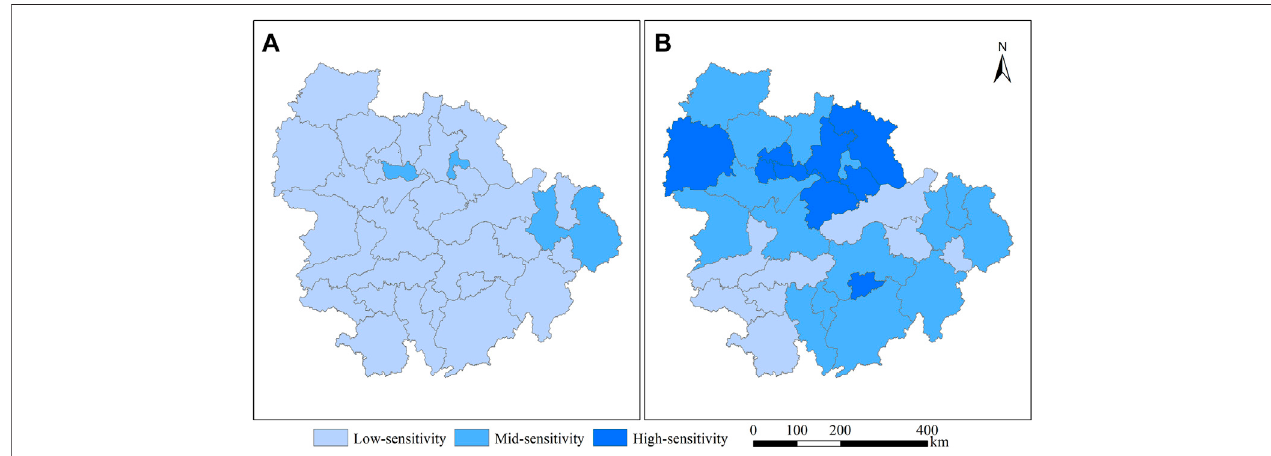
FIGURE 4 | Sensitivity of cropland expansion to construction land expansion in the periods of (A) 2000 – 2010 and (B) 2010 – 2020.